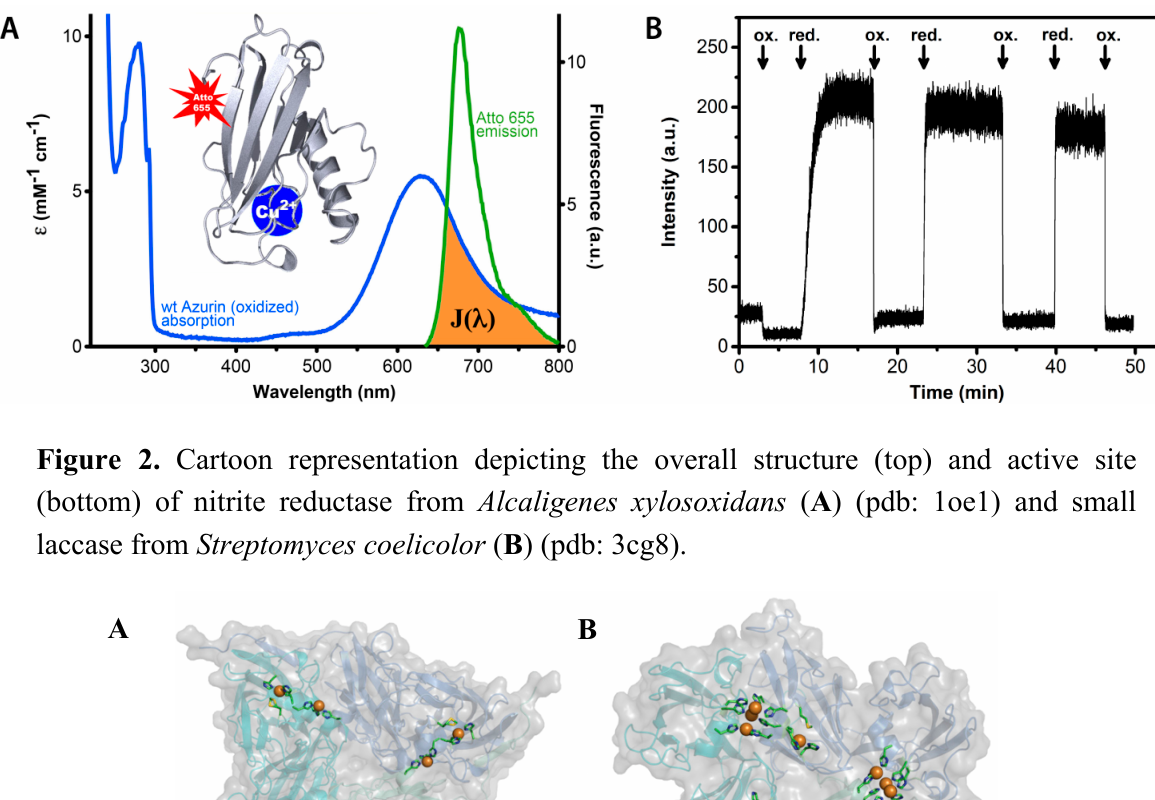
Figure 1. Redox state dependent quenching of the fluorescence of a dye label covalently attached to the blue copper protein azurin from Pseudomonas aeruginosa . ( A ) Absorption and emission spectra of azurin and label, respectively. The blue curve represents the absorption spectrum of oxidized azurin, the green curve is the fluorescence spectrum of the Atto-655 dye. The brown colored area symbolizes the spectral overlap between the dye emission and the protein absorption. The absorption band around 600 nm is absent when the redox center of azurin is reduced from Cu 2+ to Cu + . The inset shows a protein backbone ribbon presentation of the azurin structure with a site-specifically attached fluorescent label (Atto-655). ( B ) The fluorescence intensity of Atto-655-labeled azurin in solution (25 nM) is high in the reduced state and low in the oxidized state. The arrows mark the addition of excess oxidant (hexacyano-ferrate(III)) and reductant (ascorbate). In the oxidized state the fluorescence is quenched by energy transfer from the Atto-655 label to the Cu-center.